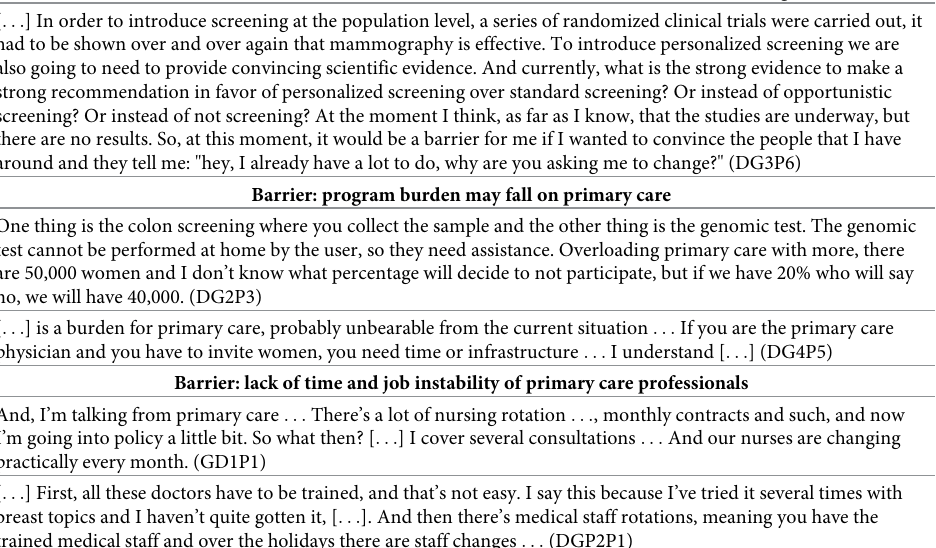
Table 4. Selected quotes from health professionals’ discussion groups on barriers and facilitators related to imple- menting a risk-based screening program. Barrier: lack of conclusive evidence on the effectiveness of risk-based screening [ ... ] In order to introduce screening at the population level, a series of randomized clinical trials were carried out, it had to be shown over and over again that mammography is effective. To introduce personalized screening we